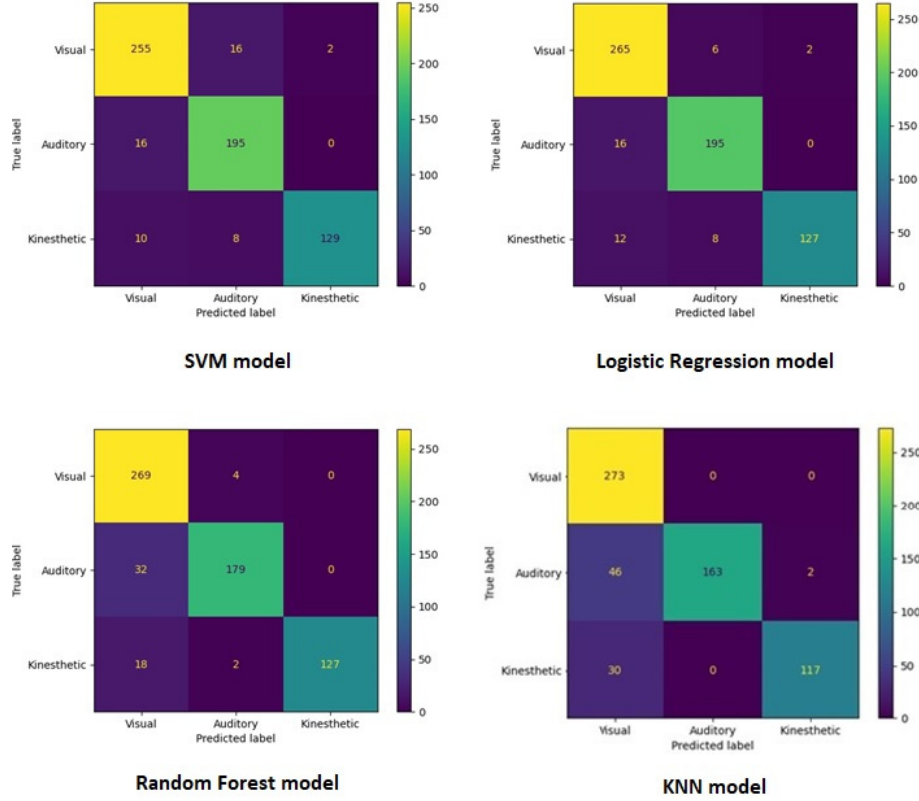
Figure 4. Confusion matrix for SVM, Logistic regression, Random Forest, and KNN models.